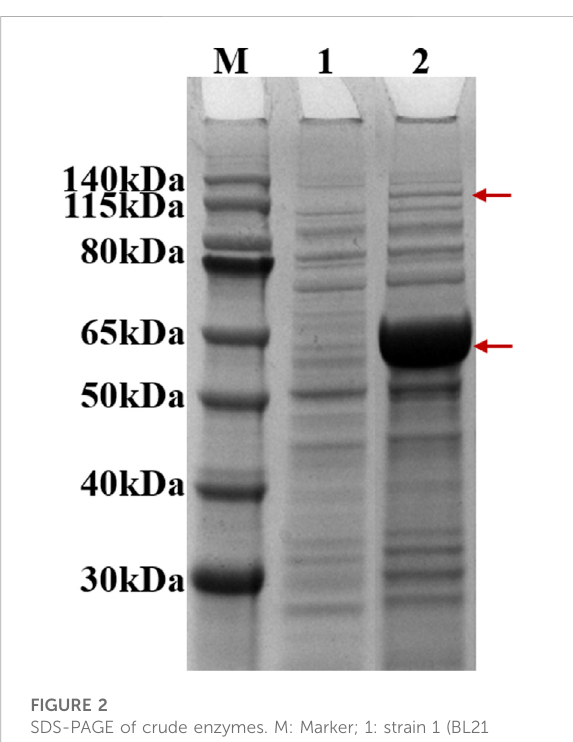
SDS-PAGE of crude enzymes. M: Marker; 1: strain 1 (BL21 (DE3)/pACYCDute1/pBAD); 2: strain 2 (BL21 (DE3)/pACYC- matBrp-Mcr /pBAD- MadLM